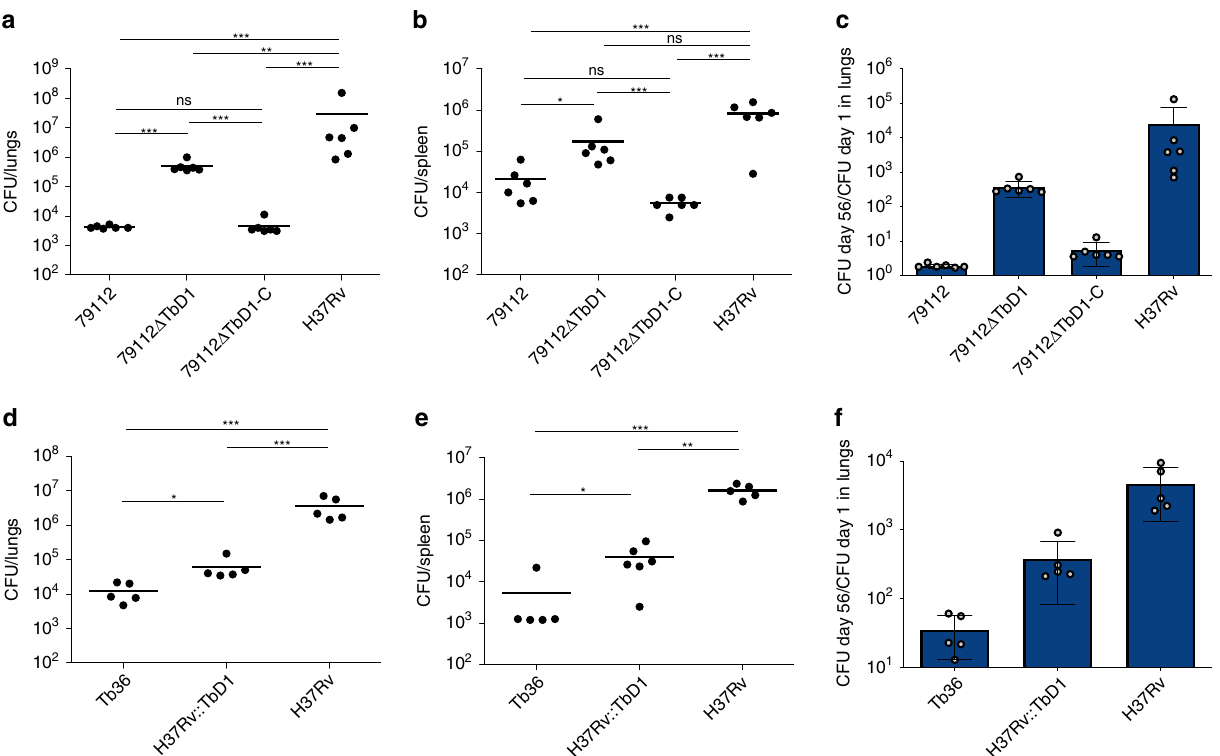
Fig. 5 Impact of TbD1 on Mtb virulence in guinea-pigs. Guinea pigs were aerosol infected with a panel of TbD1-deleted or TbD1-complemented Mtb modi fi ed strains. Eight weeks after challenge, the bacterial load in target organs was determined. a , b CFU numbers obtained in lungs ( a ) and spleen ( b ) of guinea-pigs infected with 79112 Δ TbD1 or 79112 Δ TbD1-complemented strains. Animal control groups were infected with 79112 WT or H37Rv strains. c CFU ratio (CFU at day 56/CFU at day 1) obtained in lungs of animals infected with 79112-derivative strains and 79112 or H37Rv WT strains. d , e CFU numbers obtained in lungs ( d ) and spleens ( e ) of guinea-pigs infected with the H37Rv::TbD1 strain, obtained by complementation of strain H37Rv with the TbD1 locus from strain Tb36 via cosmid 2G12. As controls, guinea pigs were infected with Tb36 and H37Rv parental strains. f CFU ratios (CFU at day 56/CFU at day 1) obtained in lungs of animals infected with the H37Rv::TbD1 strain, complemented with the TbD1 region from Tb36 via cosmid 2G12. Statistical differences in CFU values obtained in organs form animals infected with different Mtb strains were determined by the univariate analysis of variance test followed by Sidak post-hoc test (* P < 0.05; ** P < 0.01; *** P < 0.001; ns: not signi fi cant). The fi gure reports single data points, mean and standard deviation of CFU number or CFU ratio values obtained in representative experiments performed with 6 ( a – c ) or 5 ( e – f ) animals per